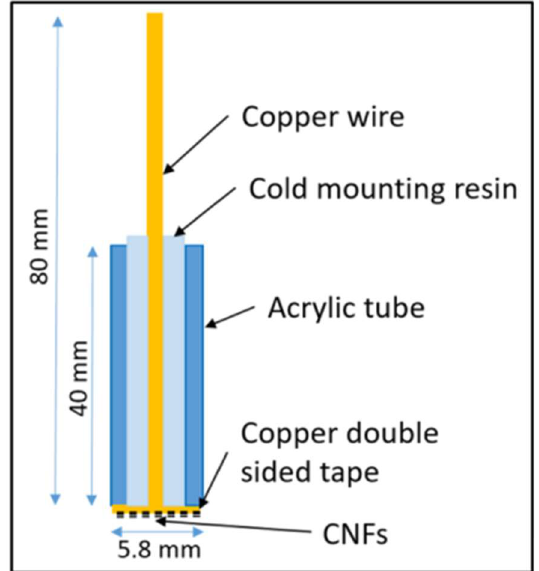
Figure 2. Schematic diagram of the electrodes.